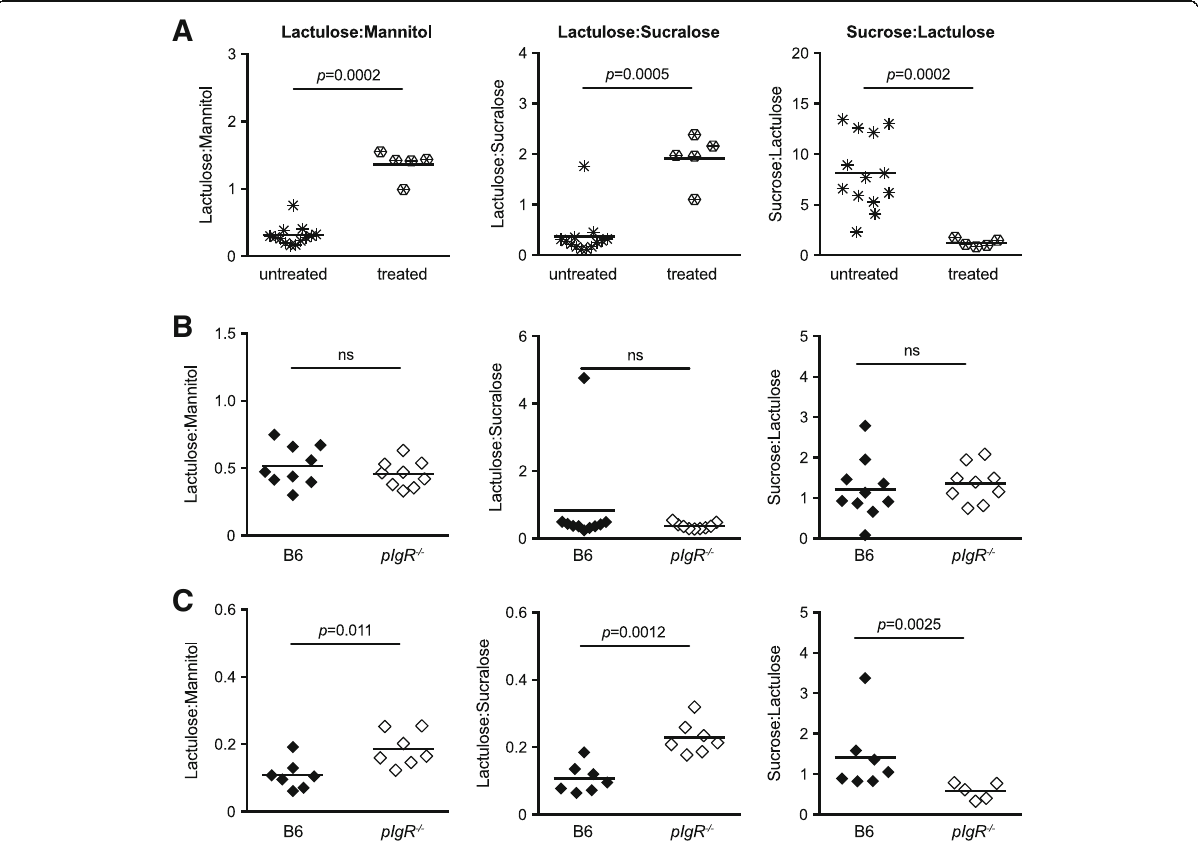
Fig. 6 Gastrointestinal permeability of older adult mice to sugar probes. Gastrointestinal permeability was measured as altered ratios of sugar probes excreted in the urine. a B6 mice were treated with 5 mg aspirin two hours prior to feeding with sugar probes (open star sign, untreated n = 14; closed star sign, treated n = 6). b 10-week old or c 22-week old female B6 (closed diamond) or pIgR − / − (open diamond) mice were given an oral dose of sugar probes containing sucrose, lactulose, sucralose and mannitol. The concentration of sugar probes in urine was collected 24-h post feeding and analysed by GC-MS. Data are represented as the ratio of sugar probe concentrations within samples and the horizontal bar represents the mean of each group. Statistical analysis was performed using the Mann Whitney U- test, ns indicates p > 0.05. Data are pooled from two independently performed